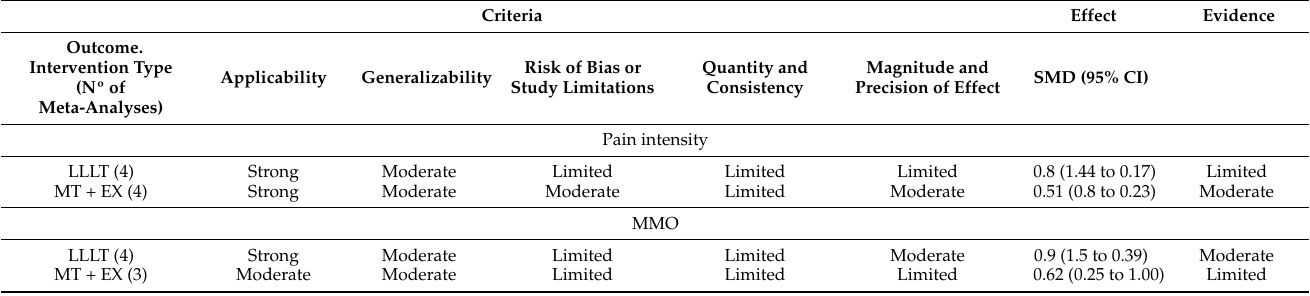
Table 5. Grades of evidence of meta-meta-analyzed variables (PAGAC). Criteria Effect Evidence Outcome. Intervention Type (Nº of